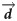
Direction and magnitude d→ of observed relative changes for urban land, with the underlying measures dair and dprc significant at the 10% level.The direction of change is indicated by colour, where I equals warmer and wetter; II colder and wetter; III colder and drier; and IV warmer and drier conditions (cf. Fig 3A). The classification of the magnitude of change corresponds to quartiles. Case city abbreviations are as follows: B, Barstow (San Bernardino County, US); BA, Barreiras (Bahia state, Brazil); BR, Brasilia (DF, Brazil); DA, Daman (India); K, Khartoum (Sudan); LA, Los Angeles (Los Angeles county, US); P, Palmas (Tocantins/Brazil); R, Rotterdam (Netherlands); S, Surat (India); UT, Utrecht (Netherlands). Highlighted in black are grid cells where the trend in (non-consecutive) heat days hd (p < 0.10) exceeds the global median trend in heat days (h˜d=+0.2 heat days/year).